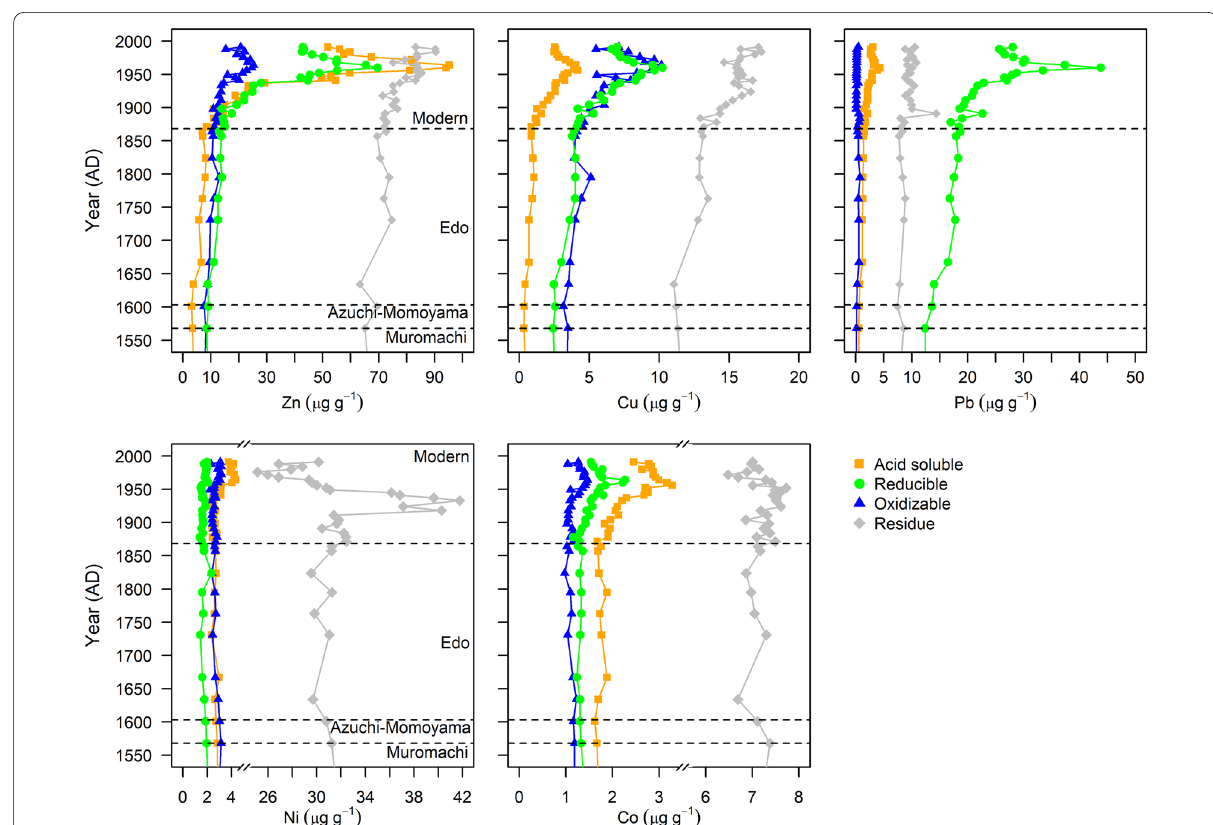
Fig. 8 Time profiles of trace metal concentrations in the leaching fractions in the piston core during the last 450 years. The horizontal lines refer to changes in trace metal